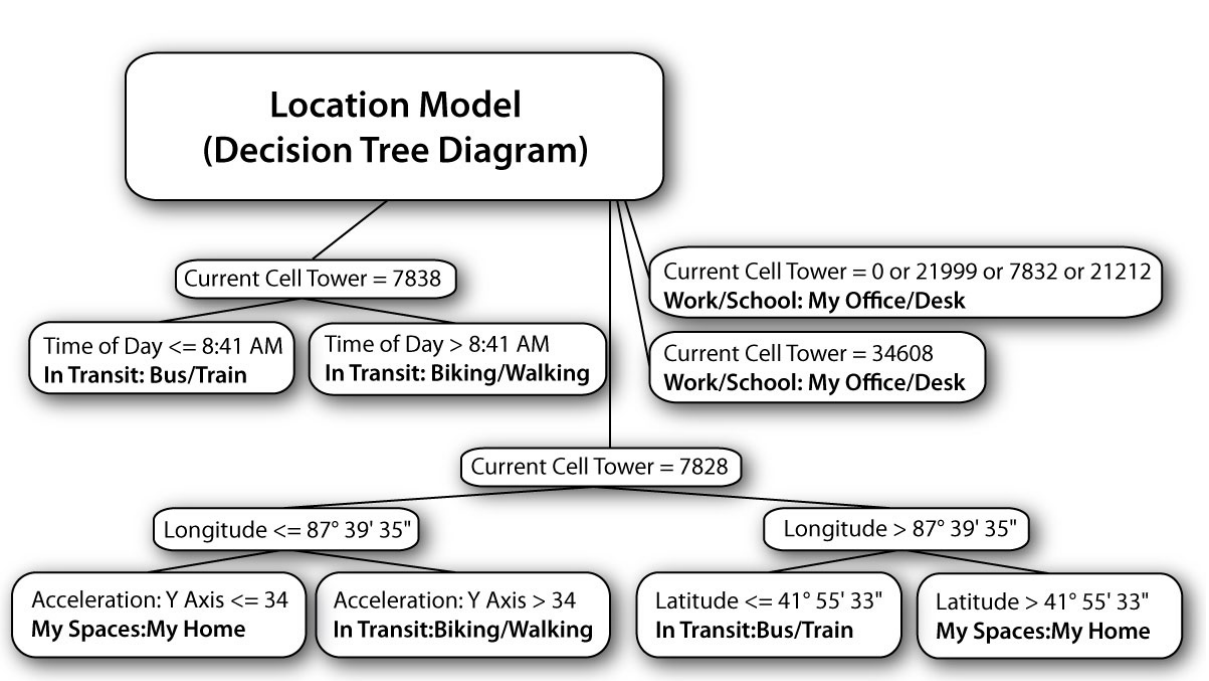
Figure 2. Decision tree model predicting location from sensor values, generated from a research staff member’s state ratings and sensor data (potentially identifying information has been